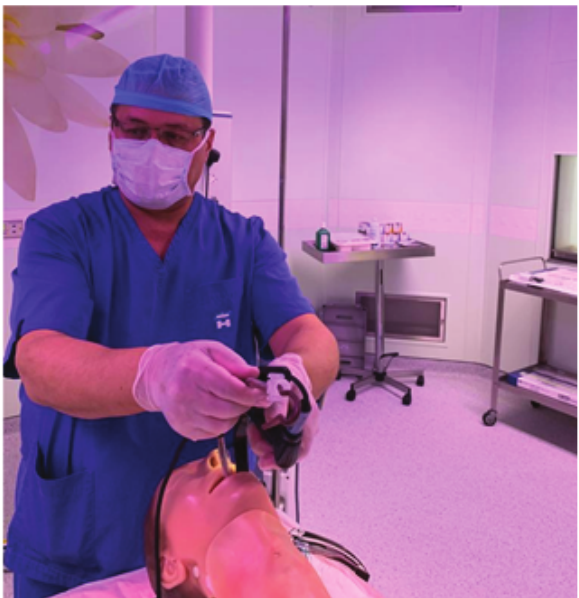
Figure 2: Combined intubation with glidescope. Both the glidescope blade and ETT are inserted together.